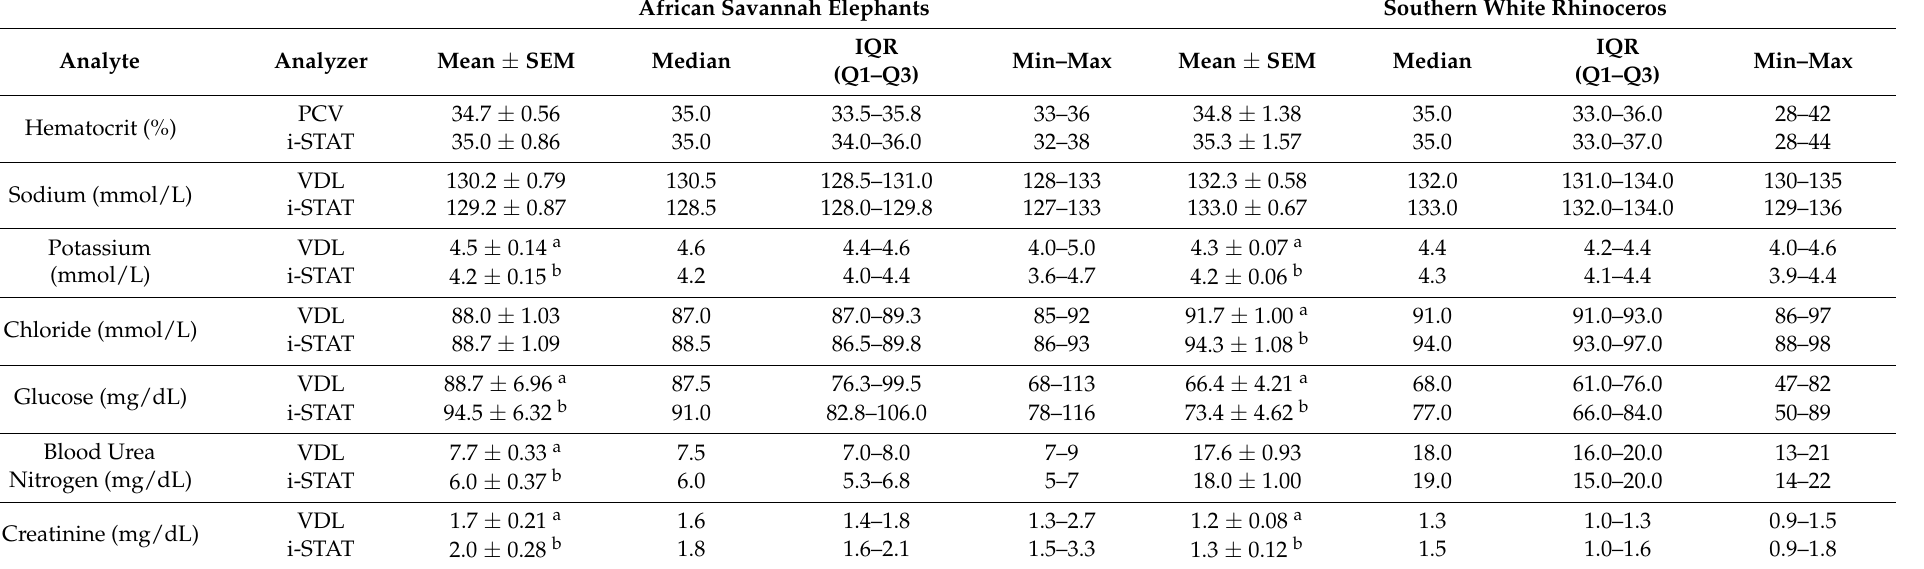
Table 2. Descriptive statistics of hematocrit and biochemical values in African savanna elephants ( Loxodonta africana ; n = 6) and southern white rhinoceros ( Ceratotherium simum simum ; n = 9) measured by the i-STAT Alinity v analyzer, manual measurement of packed cell volume (PCV), and a veterinary diagnostic laboratory